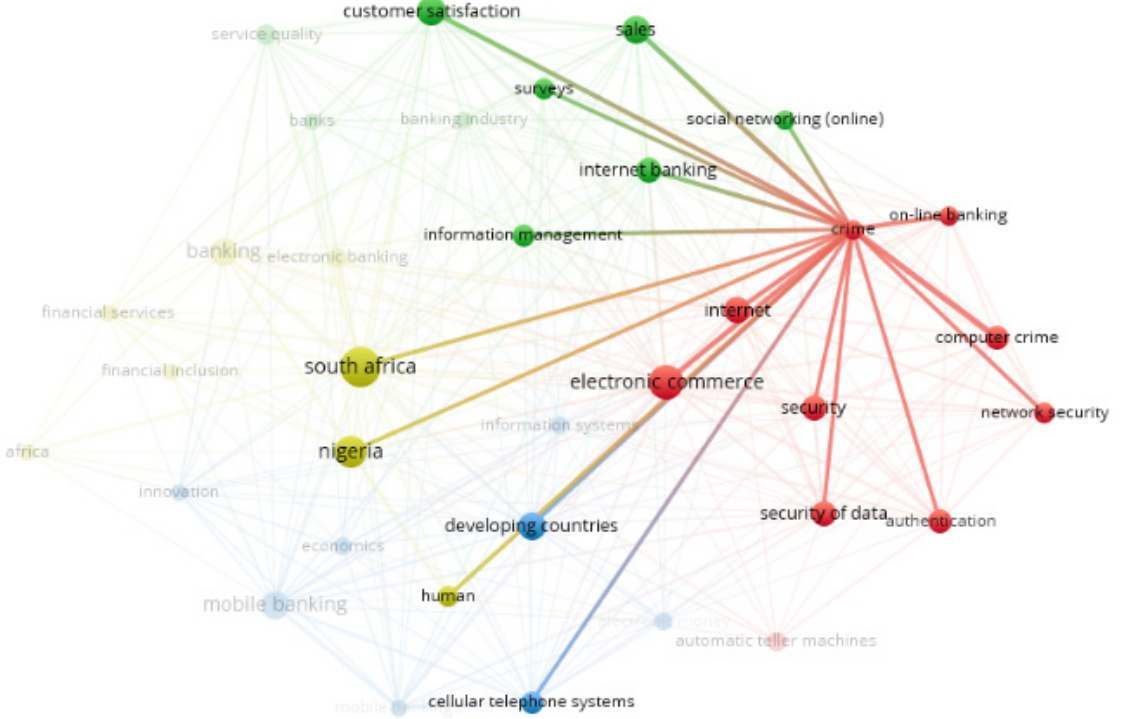
Figure 5. Isolated key phrases related to crime and banking